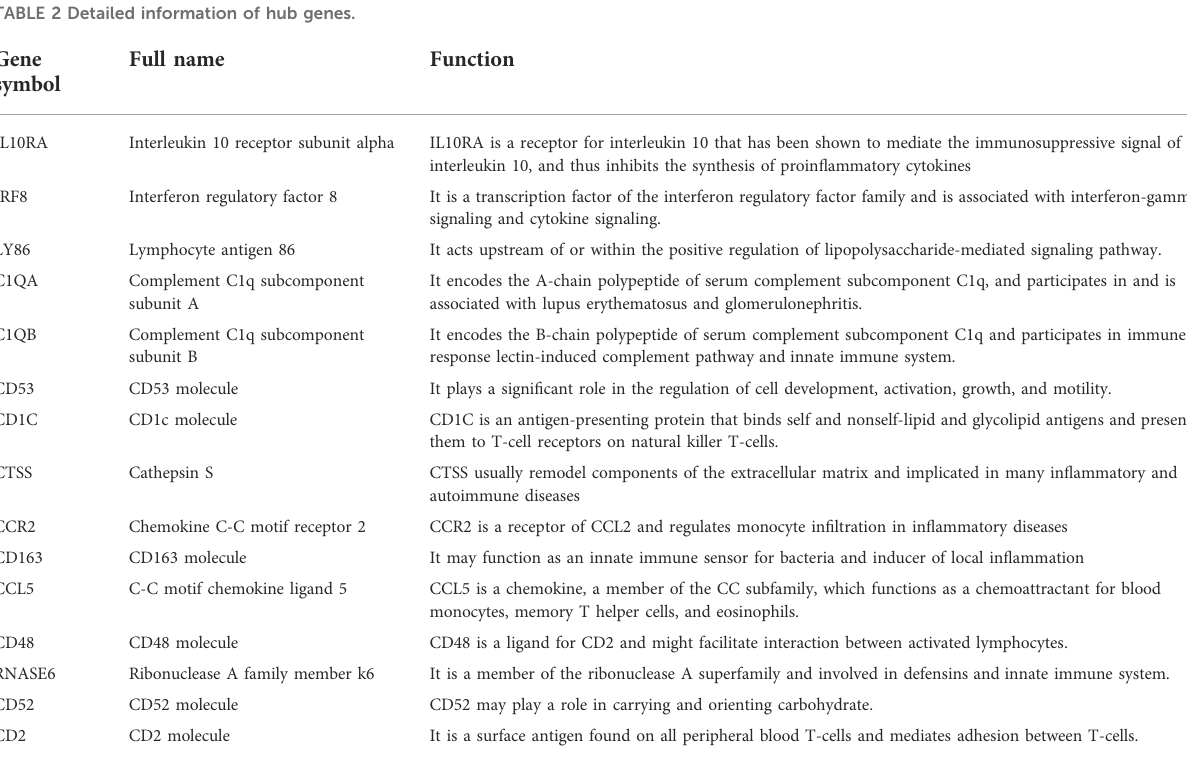
TABLE 2 Detailed information of hub